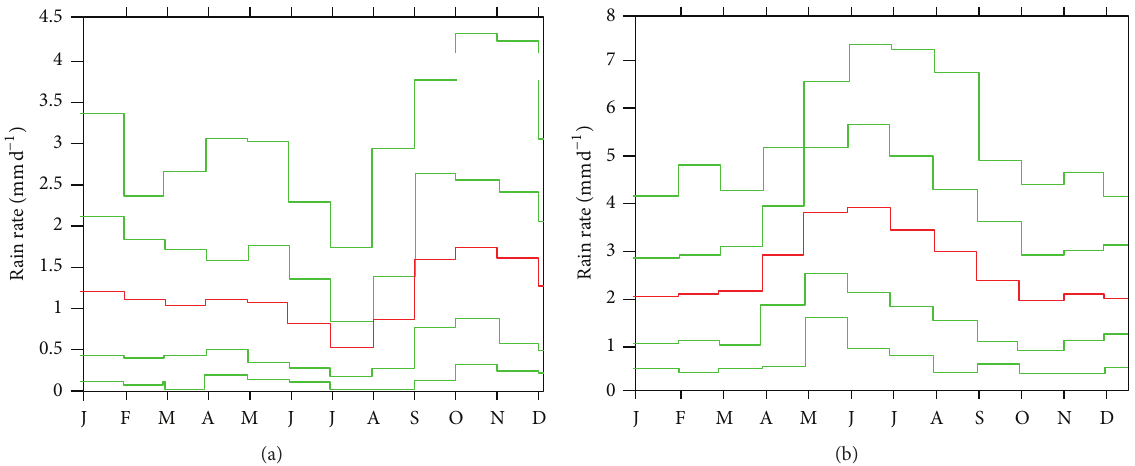
Figure 3: Mean monthly rain rates (red line) with the 25th and the 95th percentile (green lines) for (a) lower and (b) upper Rhone river basin (data arranged from NCEP Reanalysis provided via KNMI-Climate Explorer for the period 1961–2010 [57]).